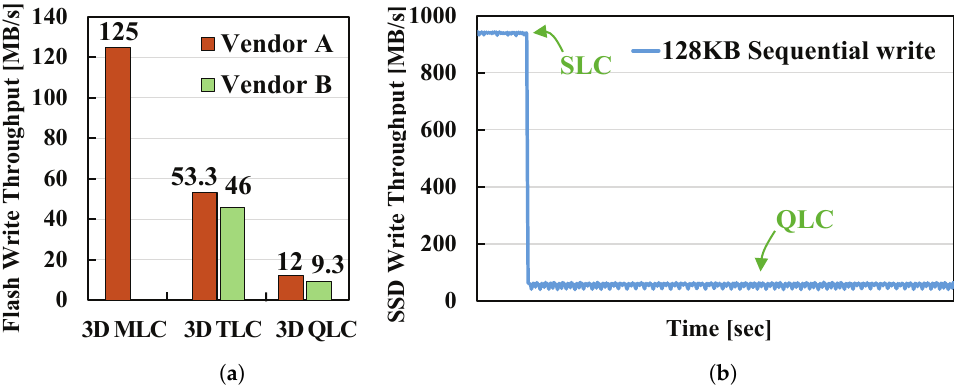
Figure 1. Performance comparisons. ( a ) Flash performance. ( b ) SLC/QLC hybrid SSD